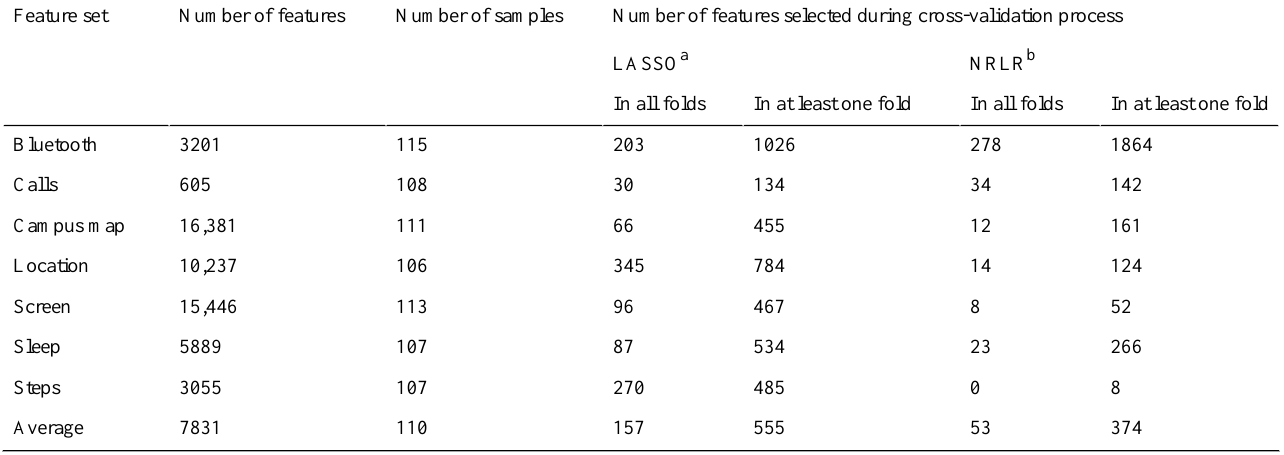
Table 1. The list of feature sets with the number of features and data samples used in the machine learning pipeline after handling missing values and the number of selected features during the cross-validation